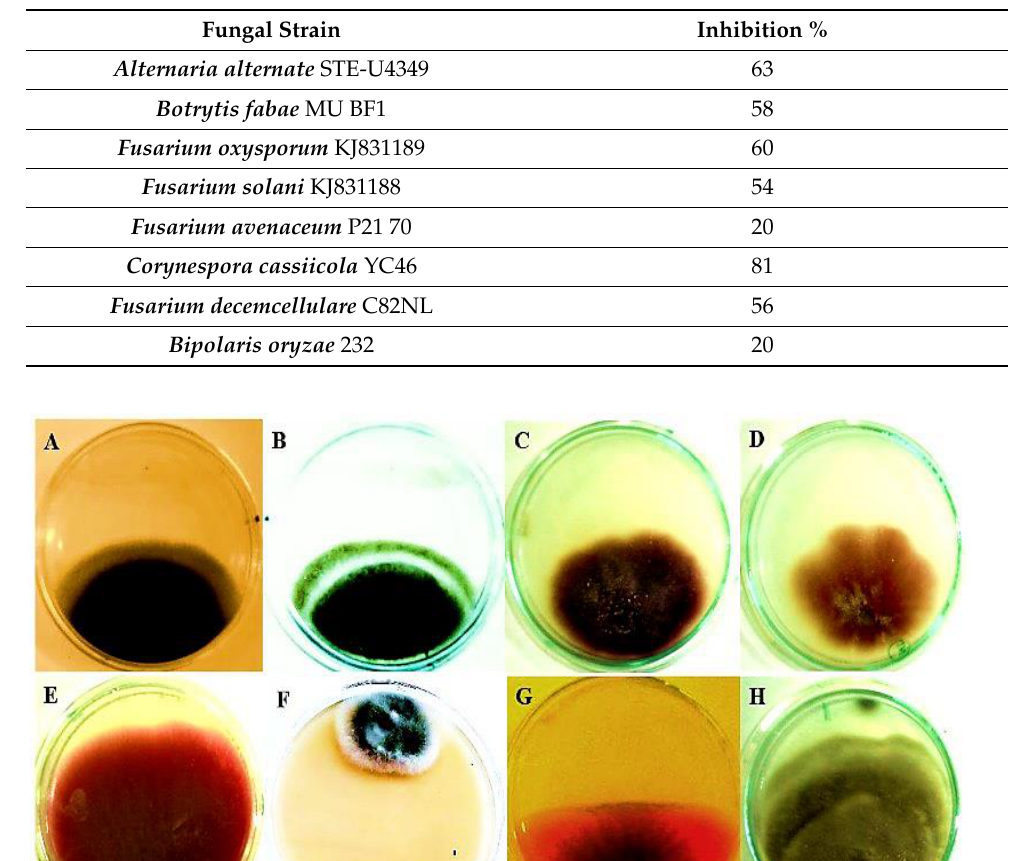
Table 5. Antifungal activity of crude xylanase against some plant pathogenic fungi.